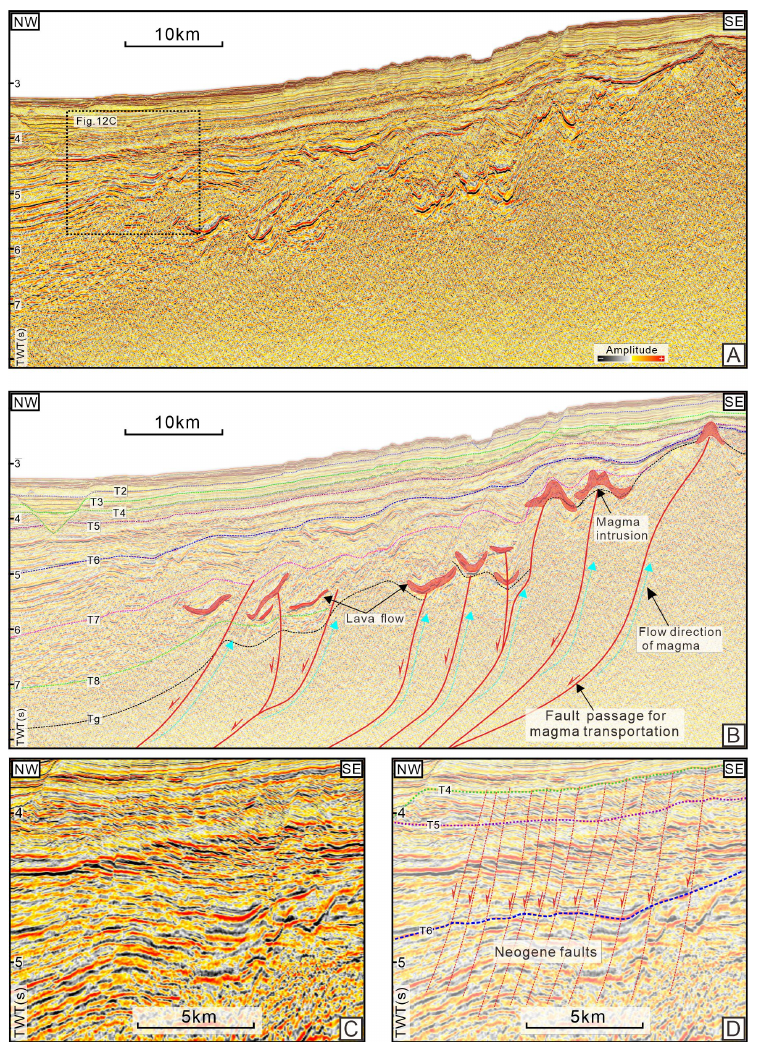
Figure 12. ( A ) Seismic profile and ( B ) its interpretation showing the magmatic intrusions associated with the deeply rooted faults (for location, see Figure 1). ( C , D ) Seismic profile and its interpretation show the dense post-rift faults developed in the eastern depression (for location, see Figure 12A). TWT = two-way traveltime.